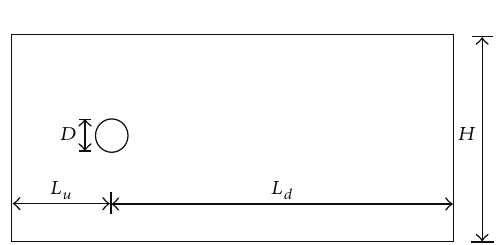
Figure 4: Configuration of the test case.